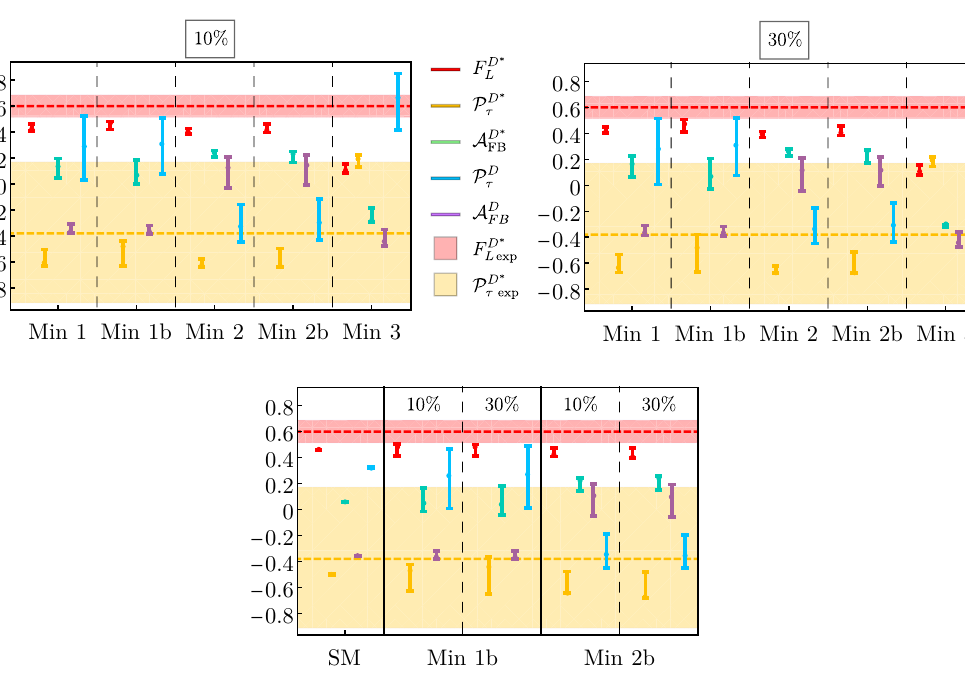
Figure 11 . The upper panels show the predictions of selected observables for the different minima without (Min 1, Min 2 and Min 3) and with (Min 1b, Min 2b) the inclusion of F D ∗ shaded areas show the experimental results at 1 σ where applicable. On the left (right) panel, a bound of ( B c τ ¯ ν τ ) 10% (30%) has been applied. The lower panel shows the predictions of B → ≤